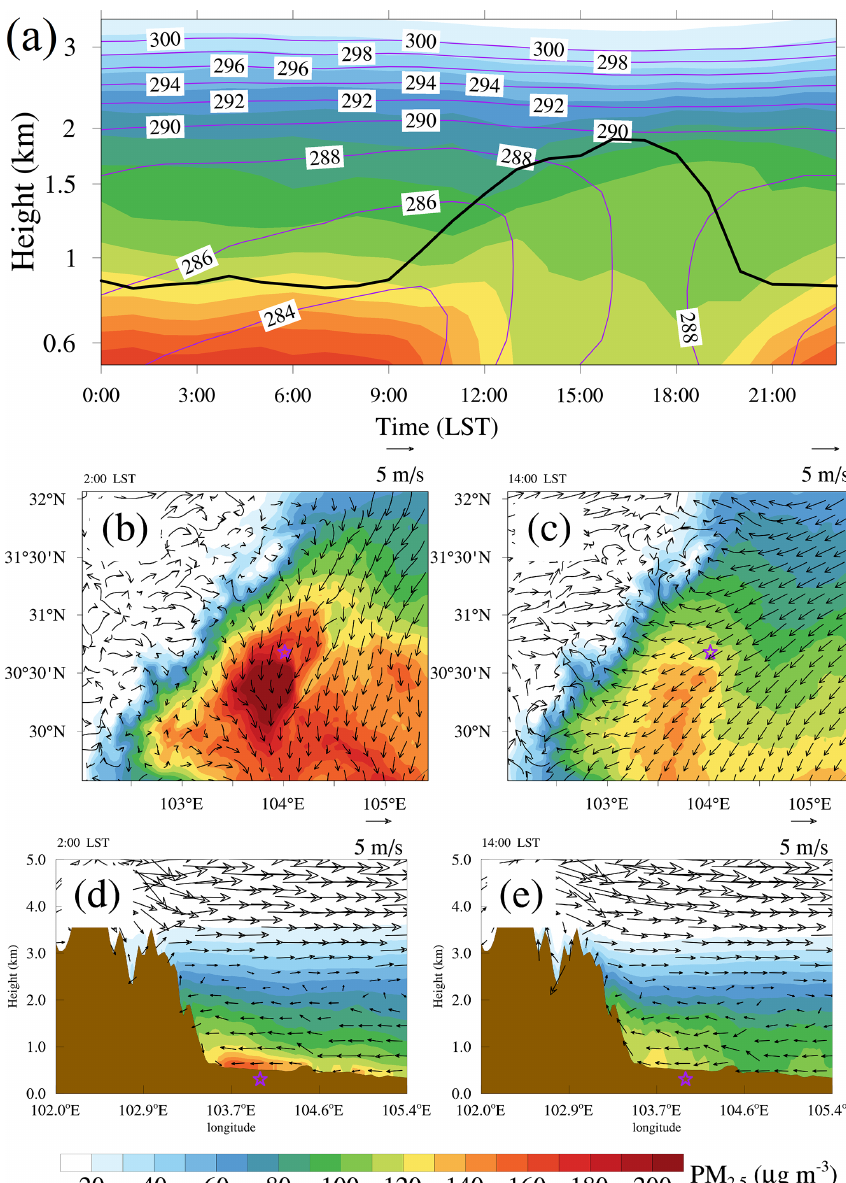
Figure 7. (a) Time–altitude cross sections of PM 2 . 5 (colored shading), potential temperature (purple contour lines) and boundary layer height (thick black contour line) at Chengdu. Panels (b) and (c) present the horizontal distributions of PM 2 . 5 with wind vectors at the lowest model level at 02:00 and 14:00LST, respectively. Panels (d) and (e) present east–west vertical cross sections of PM 2 . 5 with wind vectors at 02:00 and 14:00LST, respectively. Purple stars show the locations of Chengdu. Brown shaded areas represent the terrain. These results are the monthly average based on the Jan_Base